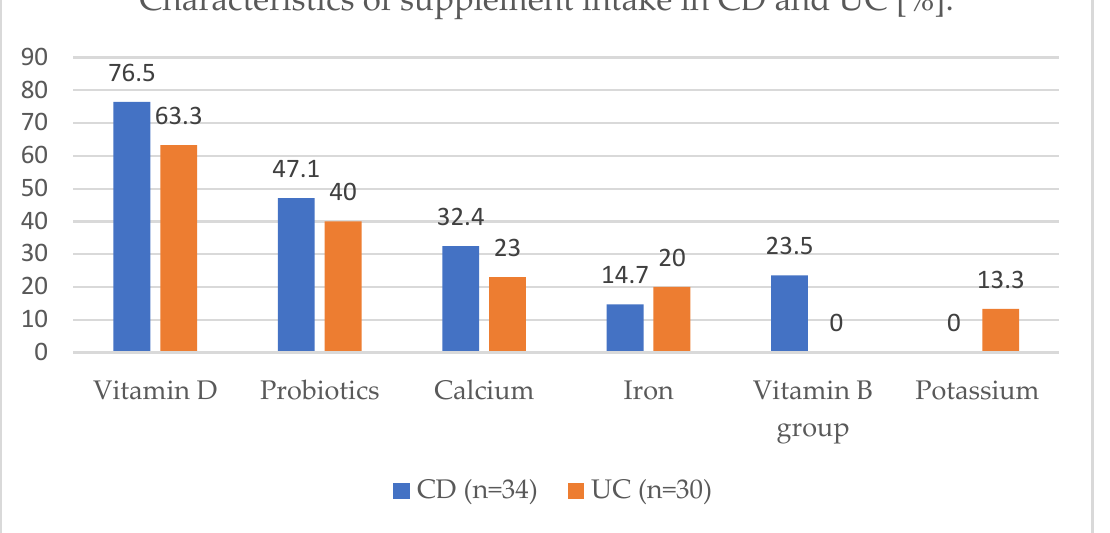
Figure 3. Characteristics of supplement intake in CD and UC (%). CD —Crohn’s disease, UC— ulcerative colitis.